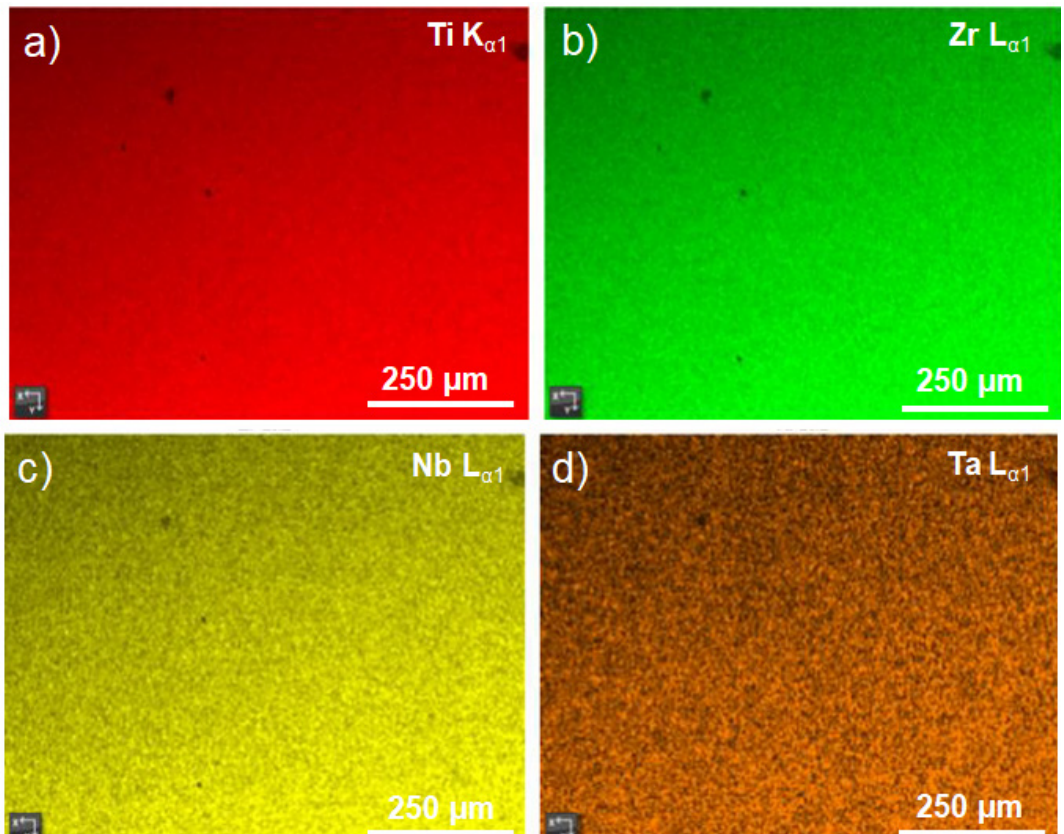
Figure 3. Map distribution of the Ti ( a ), Nb ( b ), Zr ( c ), and Ta ( d ) elements of the as-cast TNZT alloy.